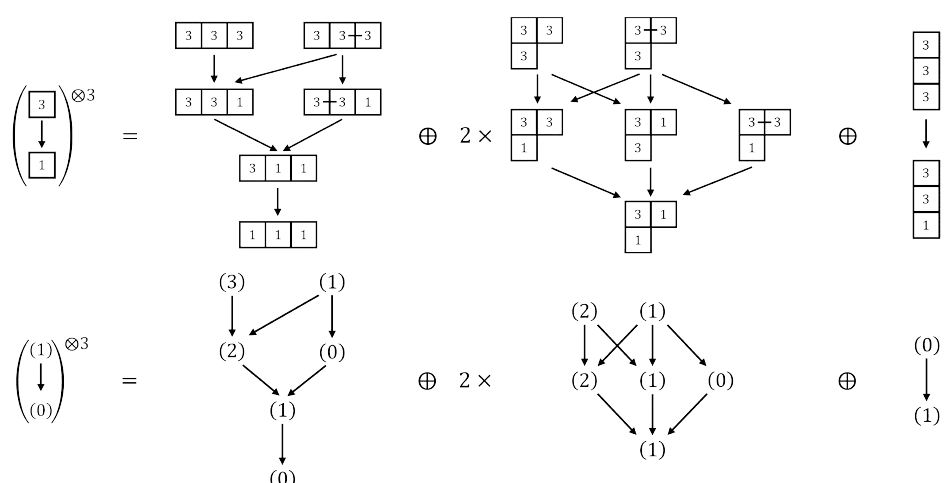
Figure 5: The rank-3 tensor representation of CCA. The upper panel shows the de- composition in terms of Young diagram, with the number in the box representing the spacial indices and temporal indices respectively. The lower panel represents the same decomposition, but now the subsectors are labeled by the representations of SO ( 3 ) directly, where ( j ) labels the spin- j representation of dimension 2 j + 1. The last summand ( 0 ) → ( 1 ) is isomorphic to the dual vector V ∨ . Since ISO ( d − 1 ) is not in SU ( d ) , the dual of V is not isomorphic to V